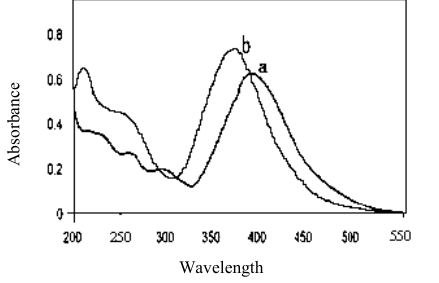
Figure 2. UV-Vis spectra of free ligands Figure 3. UV-Vis spectra of (a) [Hg